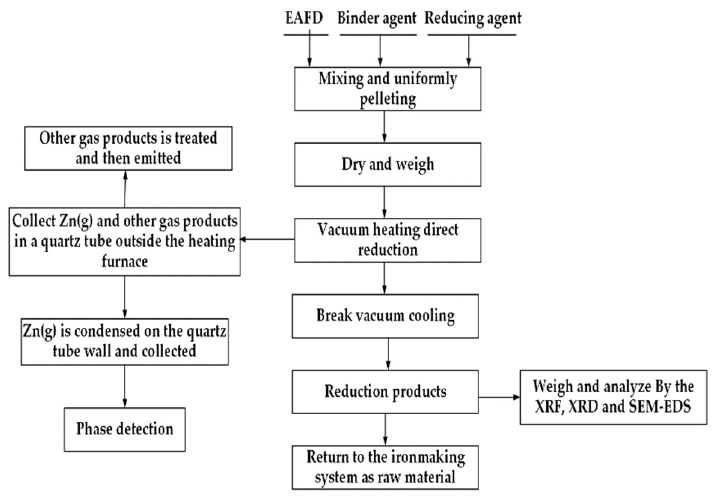
Figure 4. The experimental process.